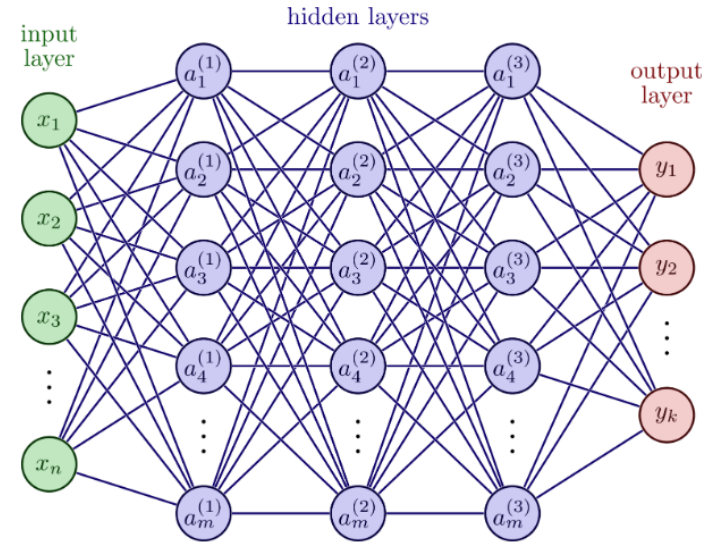
Figure 1. Artificial neural network with five